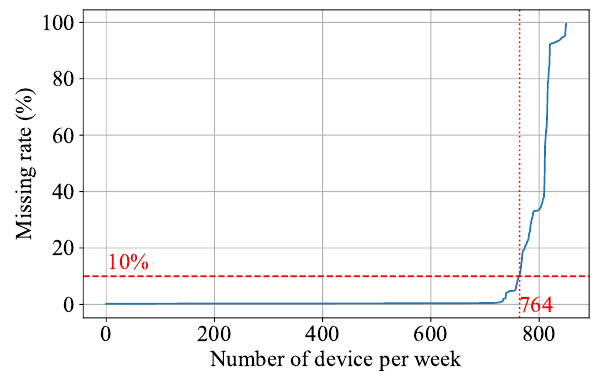
Figure 6. CO 2 missing